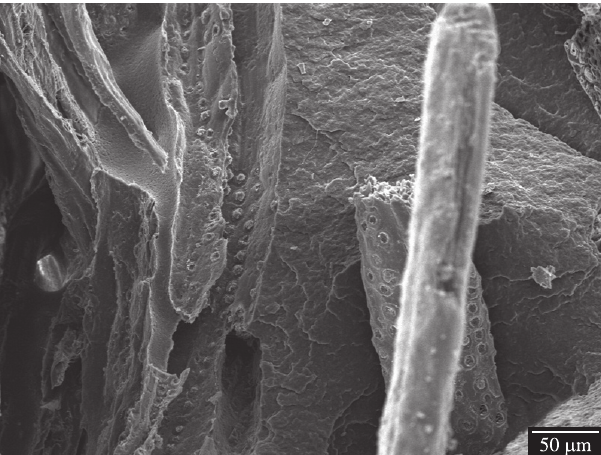
Figure 4. Detail of fiber vestiges in polypropylene/açaí fibers composite (PPA) under impact.